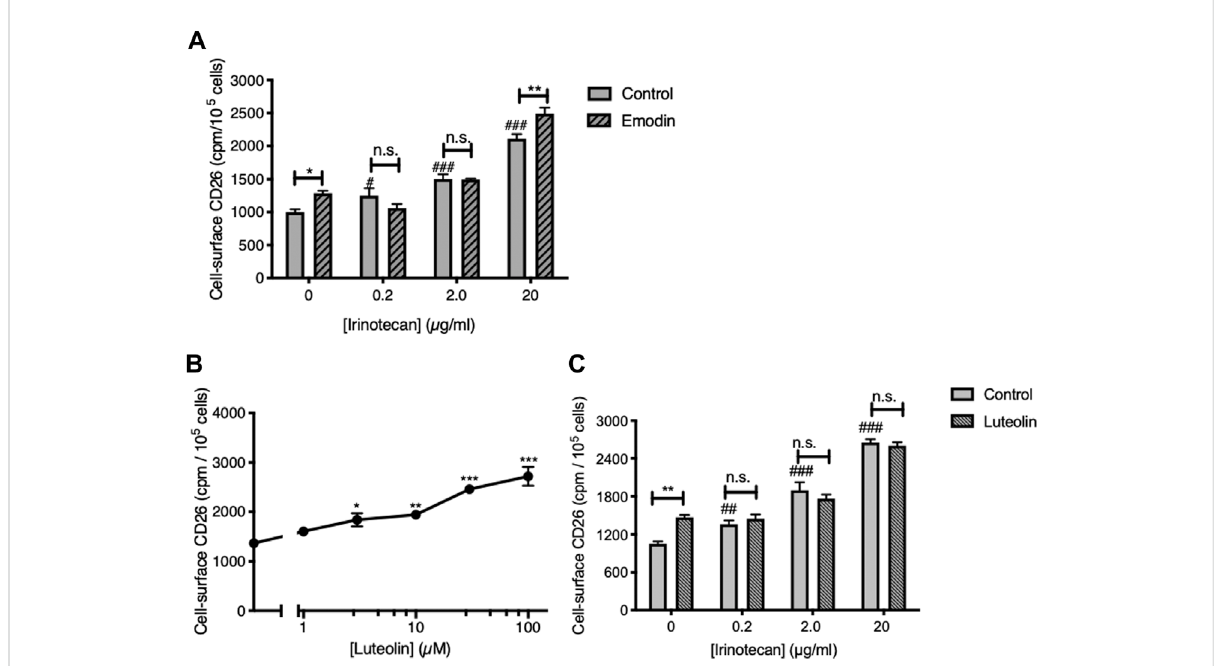
FIGURE 1 Neither CK2 inhibition, nor use of the apigenin metabolite luteolin, reproduce the interaction with apigenin seen with irinotecan. (A) The CK2inhibitoremodindoesnotenhancetheupregulationofCD26byirinotecan.HT-29cellsweretreatedwithirinotecanintheabsenceorpresence of emodin (20 µM) as indicated, and cell-surface CD26 was assessed 48 h afterward. Data are means ± SEM ( n = 4); * p < 0.05, ** p < 0.01, enhancementbyemodin;n.s.,notsigni fi cant;# p < 0.05and### p < 0.001enhancementbyirinotecan. (B) Luteolinenhancescell-surfaceCD26in a dose-dependent manner. Means ± SEM ( n = 4); * p < 0.05, ** p < 0.01 and *** p < 0.001. (C) Luteolin does not enhance the upregulation of CD26 by irinotecan. Means ± SEM ( n = 4); ** p < 0.01, enhancement by luteolin (30 µM); n.s., not signi fi cant; ## p < 0.01 and ### p < 0.001 enhancement by